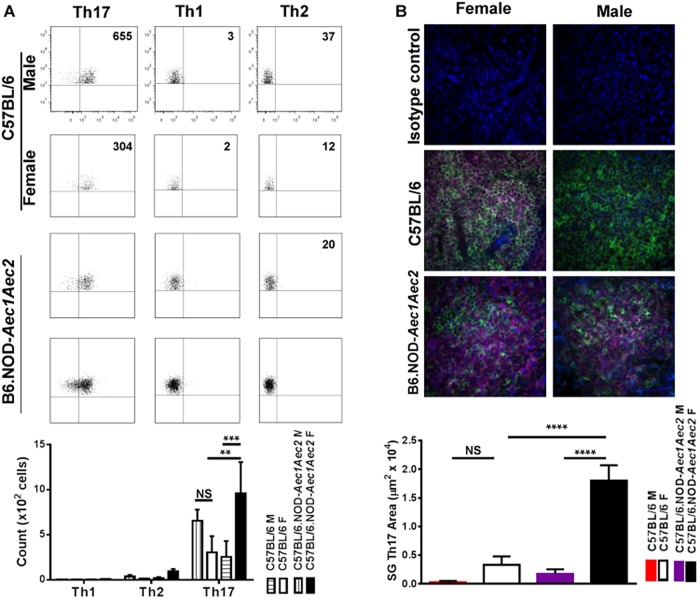
Frequency of Th17 cells in salivary glands at clinical-disease stage. Glands were excised and single-cell suspensions were isolated from male and female C57BL/6 and C57BL/6J.NOD-Aec1Aec2 mice (n=6/sex/strain, 24-33 weeks of age). Flow cytometric acquisition was performed by staining with Brilliant Violet 605 anti-mouse CD3, APC-Alexa Fluor 750 Rat anti-mouse CD4, Pacific Blue anti-mouse IFN-γ, PerCP/Cy5.5 anti-mouse IL-17A, and PE/Cy7 anti-mouse IL-4. Data was analyzed by FlowJo software. Results shown are representative data with cell count numbers presented. Average cell counts with standard of error bars for Th1, Th2, and Th17 cells of each group were presented in the bar graph (A). Immunofluorescent staining for CD4 and IL-17 were performed on paraffin-embedded sections of the salivary glands of male and female C57BL/6 and C57BL/6J.NOD-Aec1Aec2 mice (n=6/sex/strain, 24-33 weeks of age). Negative controls were performed with rabbit IgG isotype. Representative images were presented at 200× magnification (B). Area of salivary gland Th17 cell was enumerated using binary densitometrical analysis on Nikon Elements software. (CD4+, AF488-green; IL-17A+, AF647-pink; DAPI, blue) (B). The significance for each was calculated by two-way ANOVA. Error bars indicates s.e.m. with **P<0.01, ***P<0.001, ****P<0.0001.